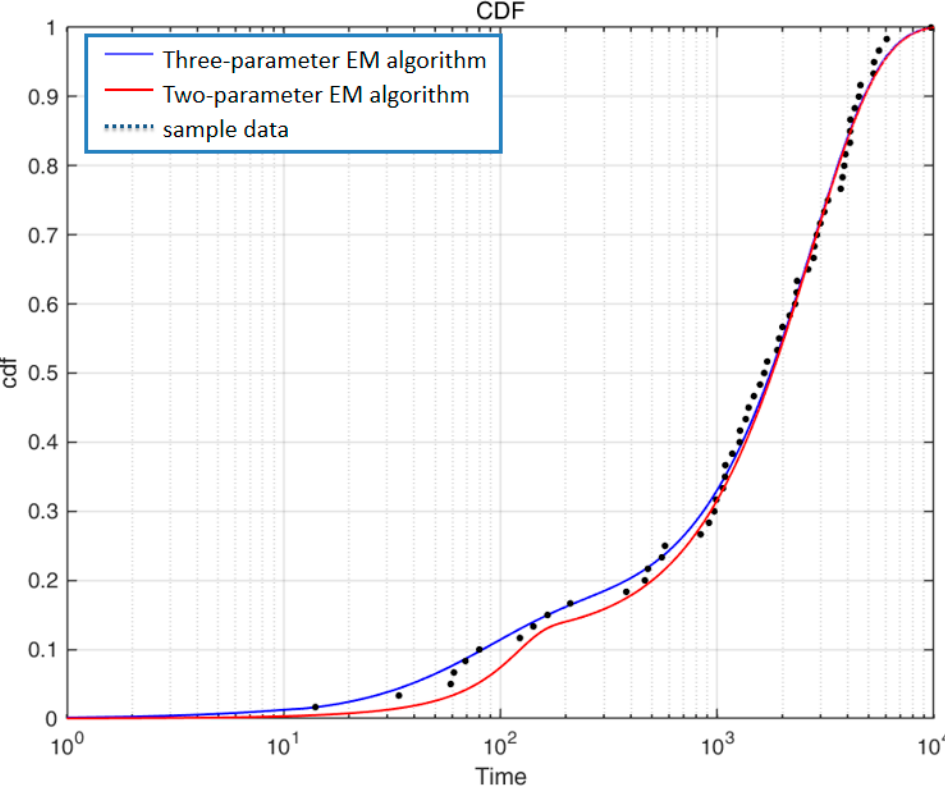
Figure 7. Failure probability fitting curve of three‑parameter mixed mode.